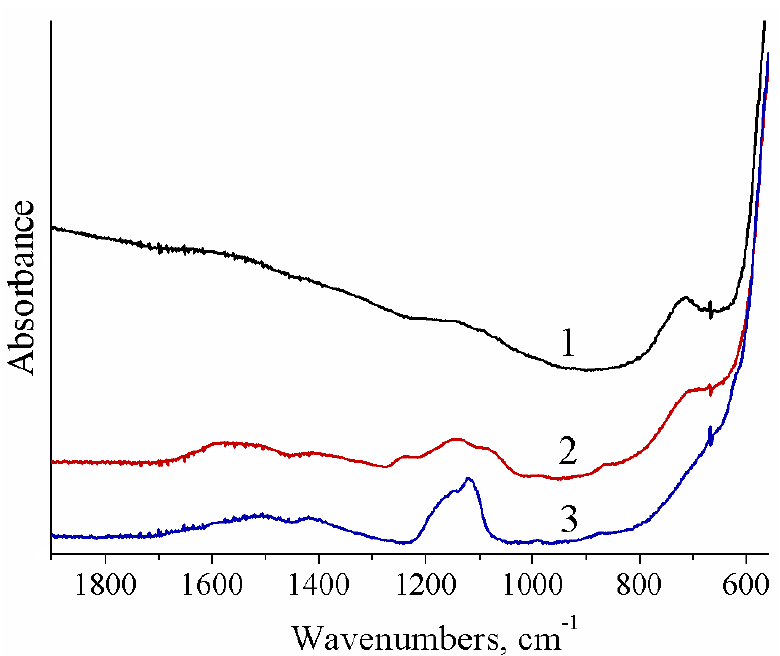
Figure 1. IR spectra of residues of the NC3 (1), NC3_0.2P (2), and NC3_1S (3) hybrid membranes after annealing at 800 ° С .